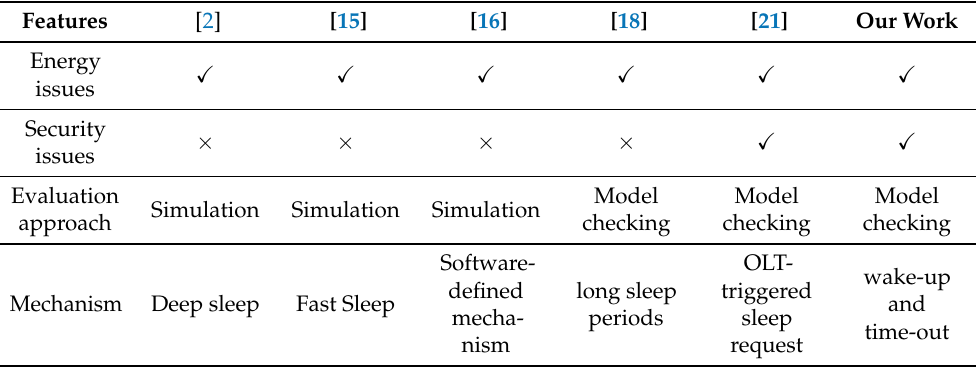
Table 1. Comparison of related works with respect to the main features of the current